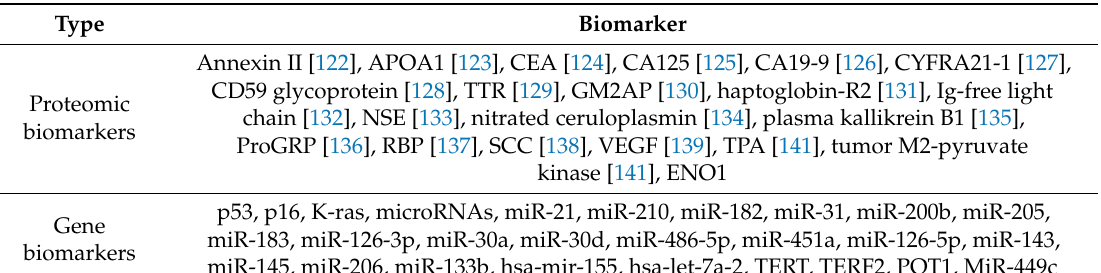
Table 3. Lung cancer markers.